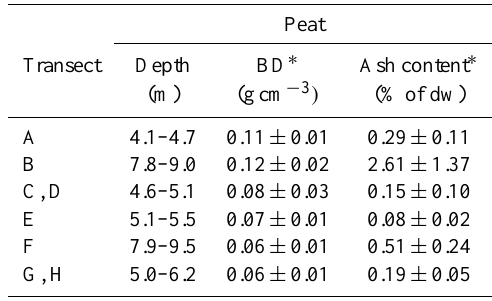
Table 1. Main characteristics of the peat at the CO 2 monitoring